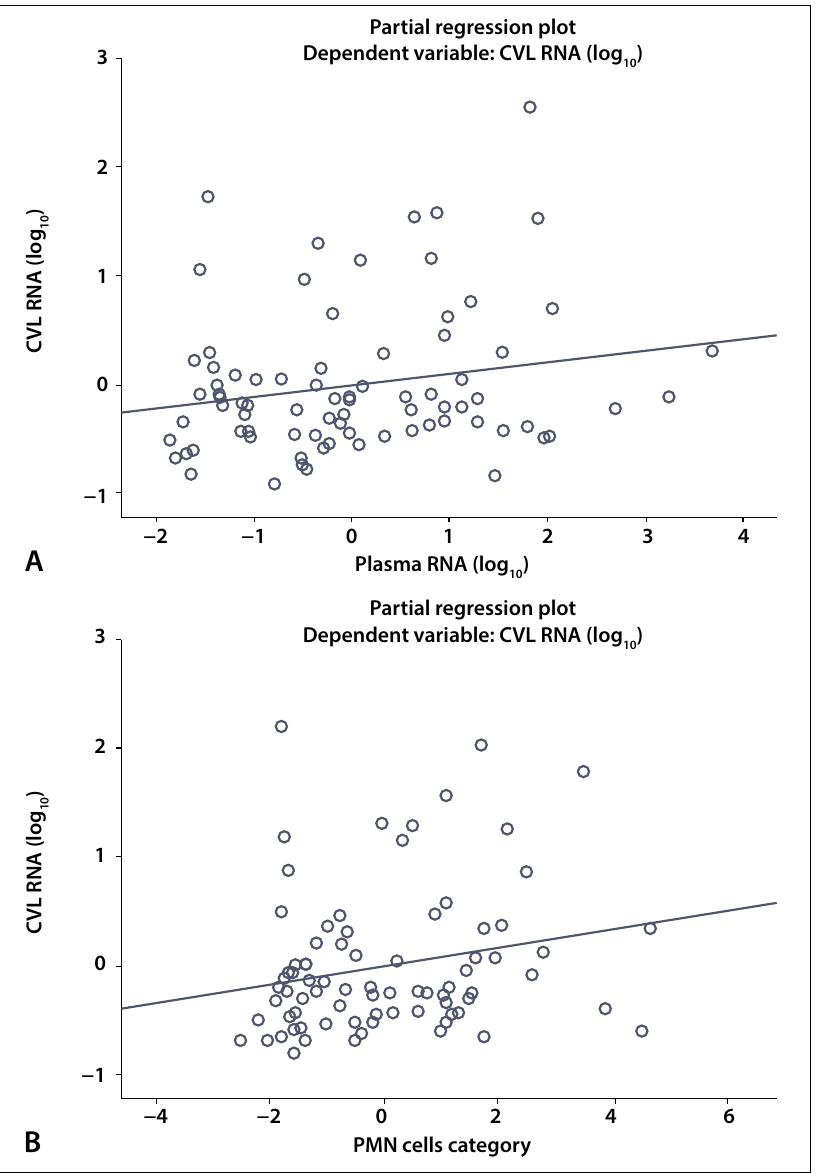
Fig. 3. Variation of genital HIV RNA levels as predicted by (A) plasma HIV loads ( r =0.2, R 2 =0.04; p =0.032) and (B) genital PMN cells ( r= 0.21, R 2 = 0.045; p= 0.007). (CVL = cervicovaginal lavage; PMN = polymorphonuclear